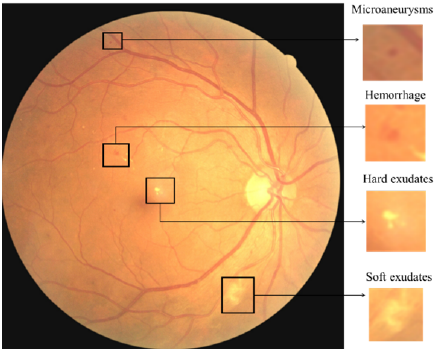
Figure 1. The different types of DR lesions.